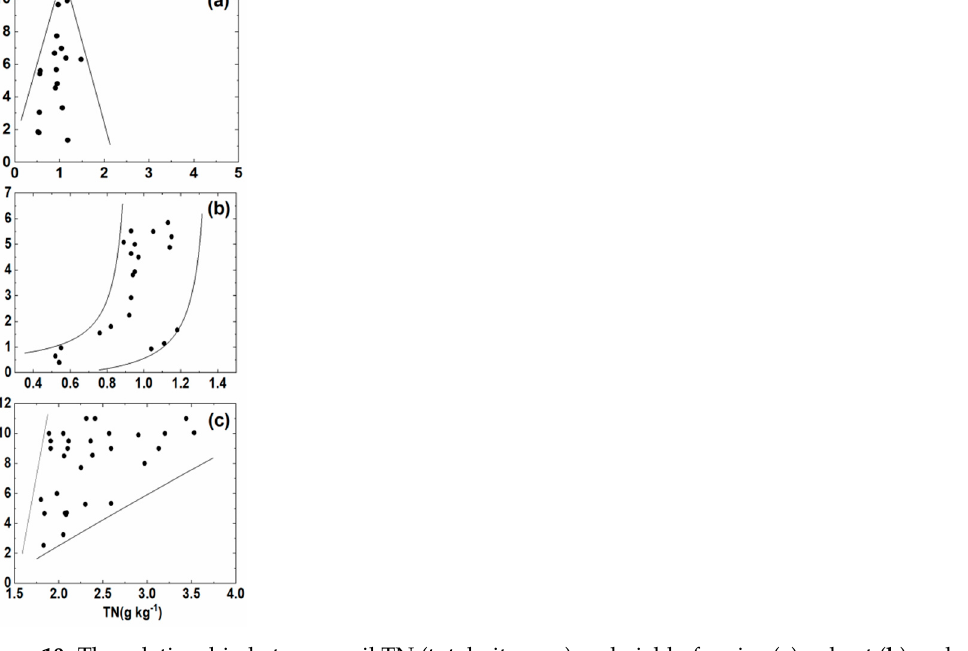
Figure 10. The relationship between soil TN (total nitrogen) and yield of maize ( a ), wheat ( b ) and rice ( c ). The lines represent range of crop yield changing with TN content.